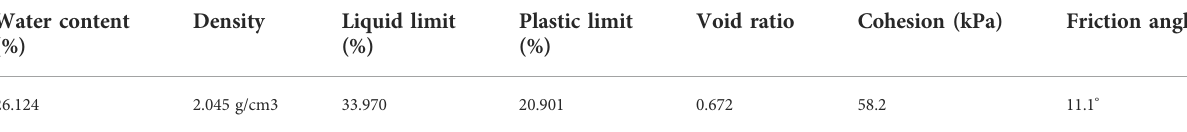
TABLE 1 Basic physical properties of the test soil.